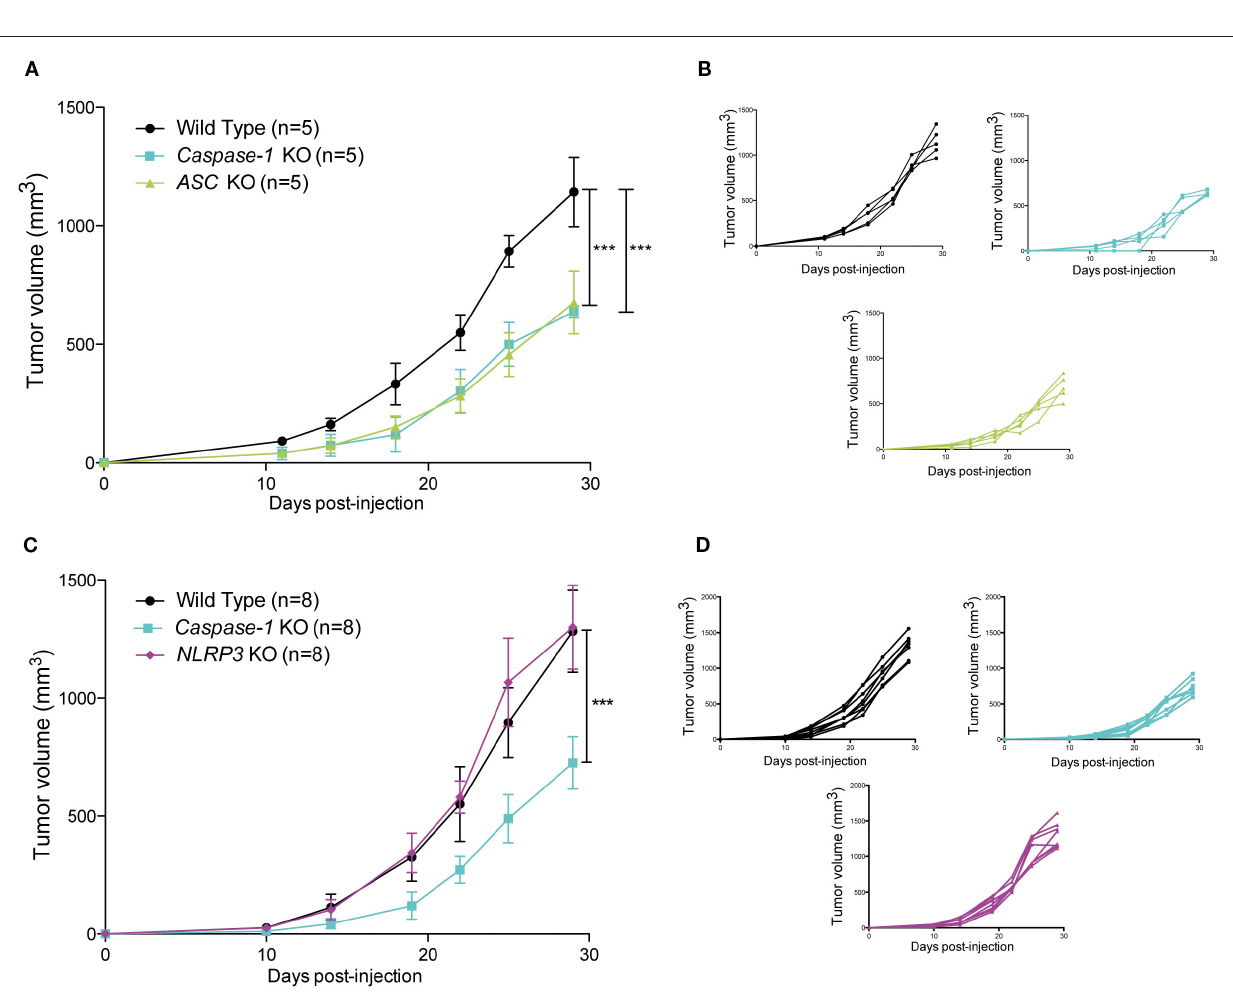
Frontiers in Oncology | www.frontiersin.org